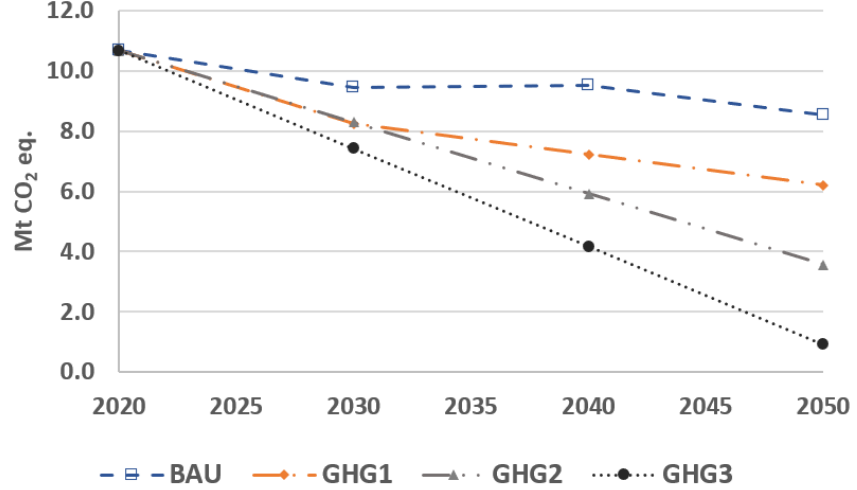
Figure 3. Total GHG emissions for different environmental scenarios.